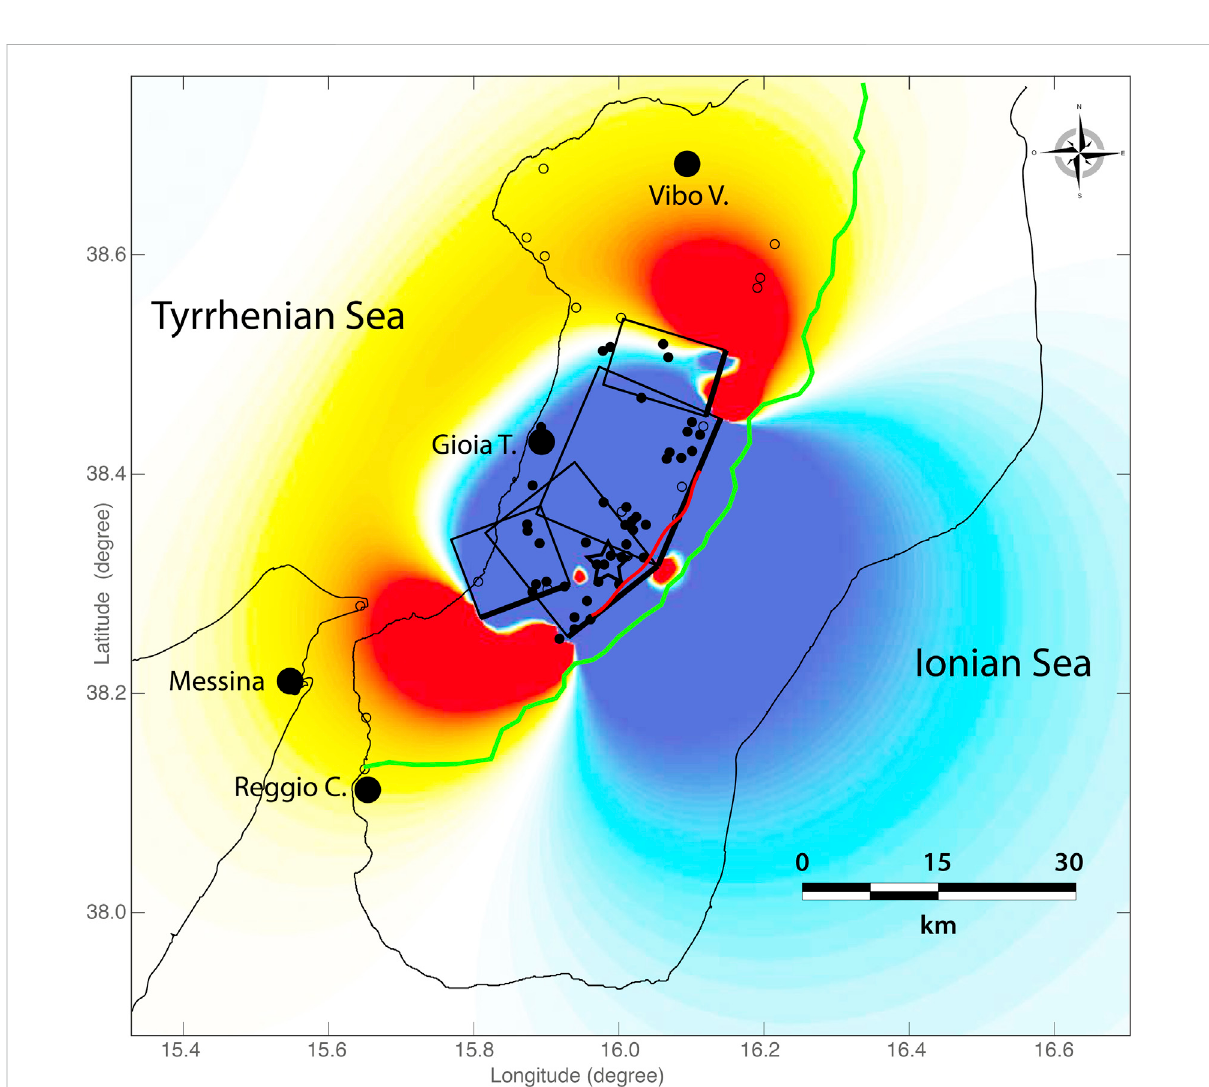
FIGURE 8 Coseismis strain fi eld induced by the Jacques potention source of the 1783 earthquake. Blue shading indicates areas in compression red shading areas in dilatation. Units:10 -5 . The thicker black line is the intersection of theupdip projection ofeach fault segment with the surface. Circles show thelocation ofall theobservedhydrological effects (both positive andnegative) that arein agreement (solid circles) or indisagreement(empty circles) with the expected deformation. A red line marks the pattern of the 20 km-long surface ruptures observed in the ground after the event. A green line shows the location of the watershed of the drainage between the Tyrrhenian Sea (West) and the Ionian Sea (East).